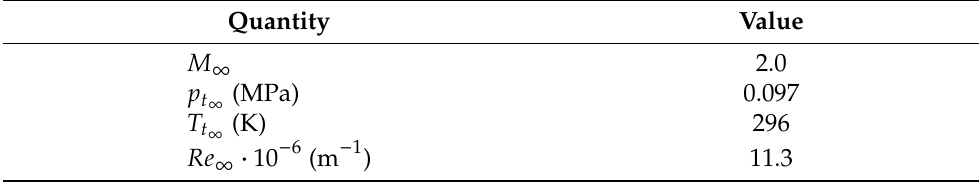
Figure 55. Interaction of arc plasma discharge with shock wave turbulent boundary layer. Reprint from [107] with the permission of AIP Publishing. Table 20. Flow Conditions.